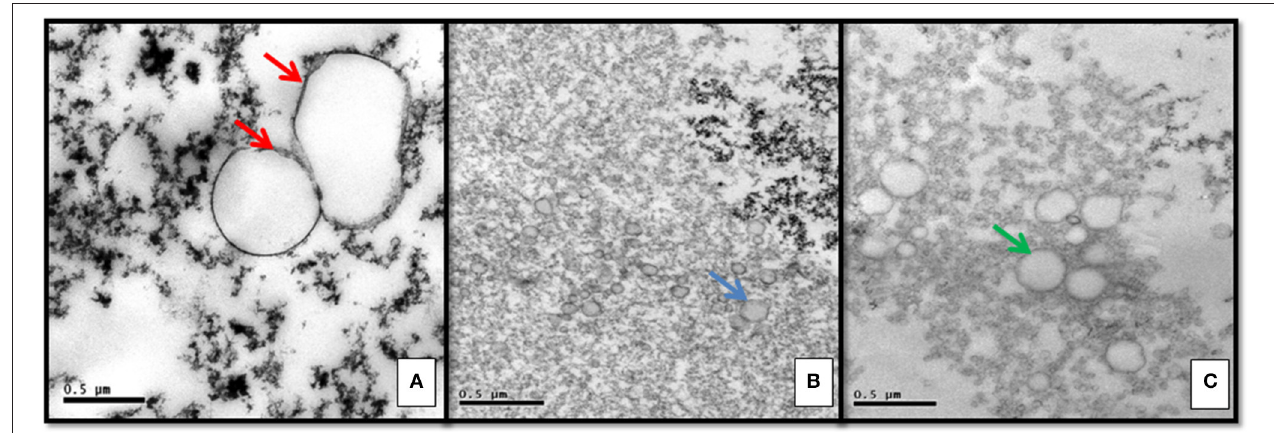
FIGURE 1 | Ultrastructural morphology of vesicles in serum supernatant: (A) Heart failure chagasic form exhibiting pathogenic archaea with double membrane surrounding clear vesicles (red arrows). (B) Indeterminate form with electron dense protective microvesicles (blue arrow). (C) Negative control group exhibiting lipidic microvesicles, surrounded by monolayer membrane (green